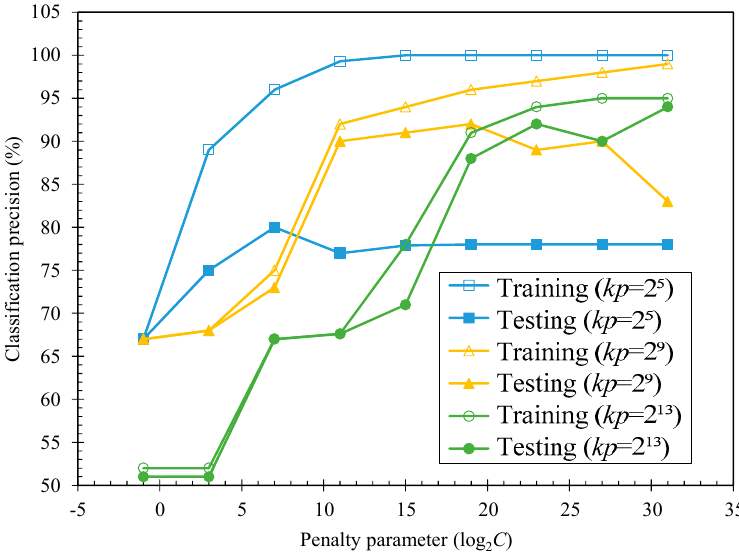
Figure 6. Classification precision–penalty parameter C relation.